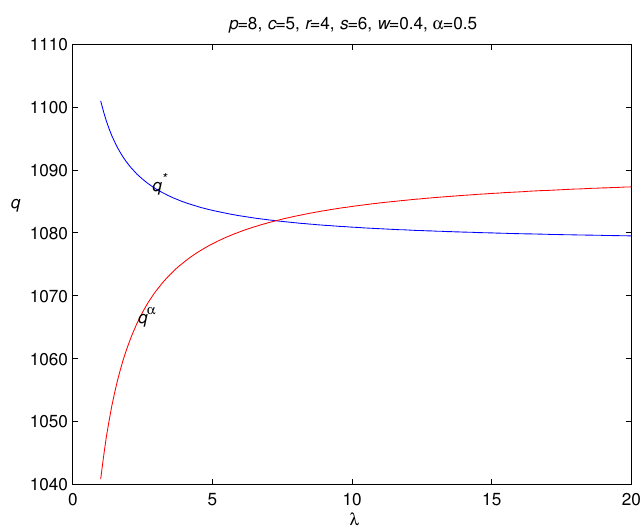
Figure 4. Optimal order quantities q ∗ and q α with different loss aversion coefficient λ